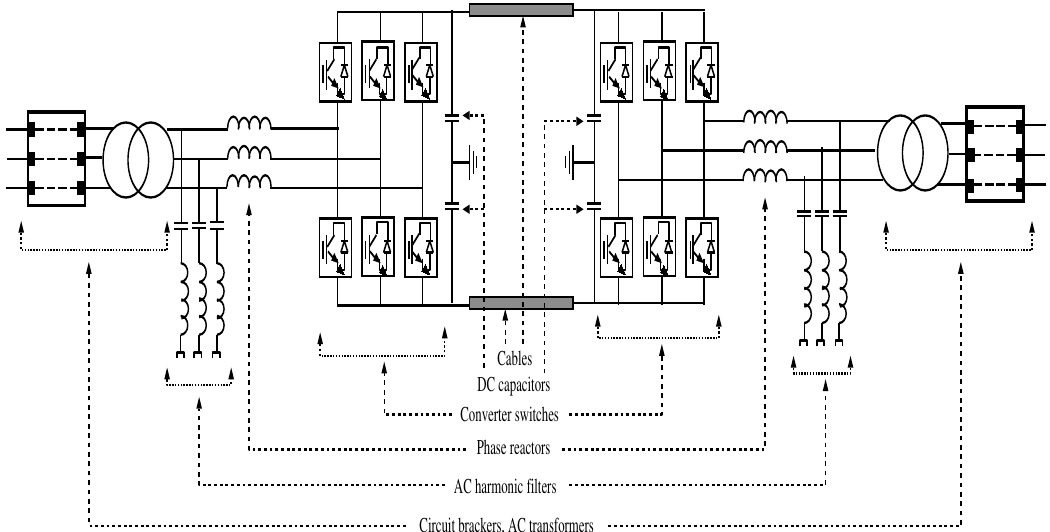
Figure 4. Configuration of a VSC-HVDC